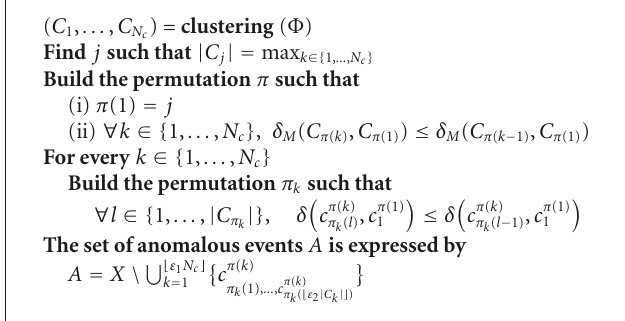
Algorithm 2: A = anomaly detection ( Φ